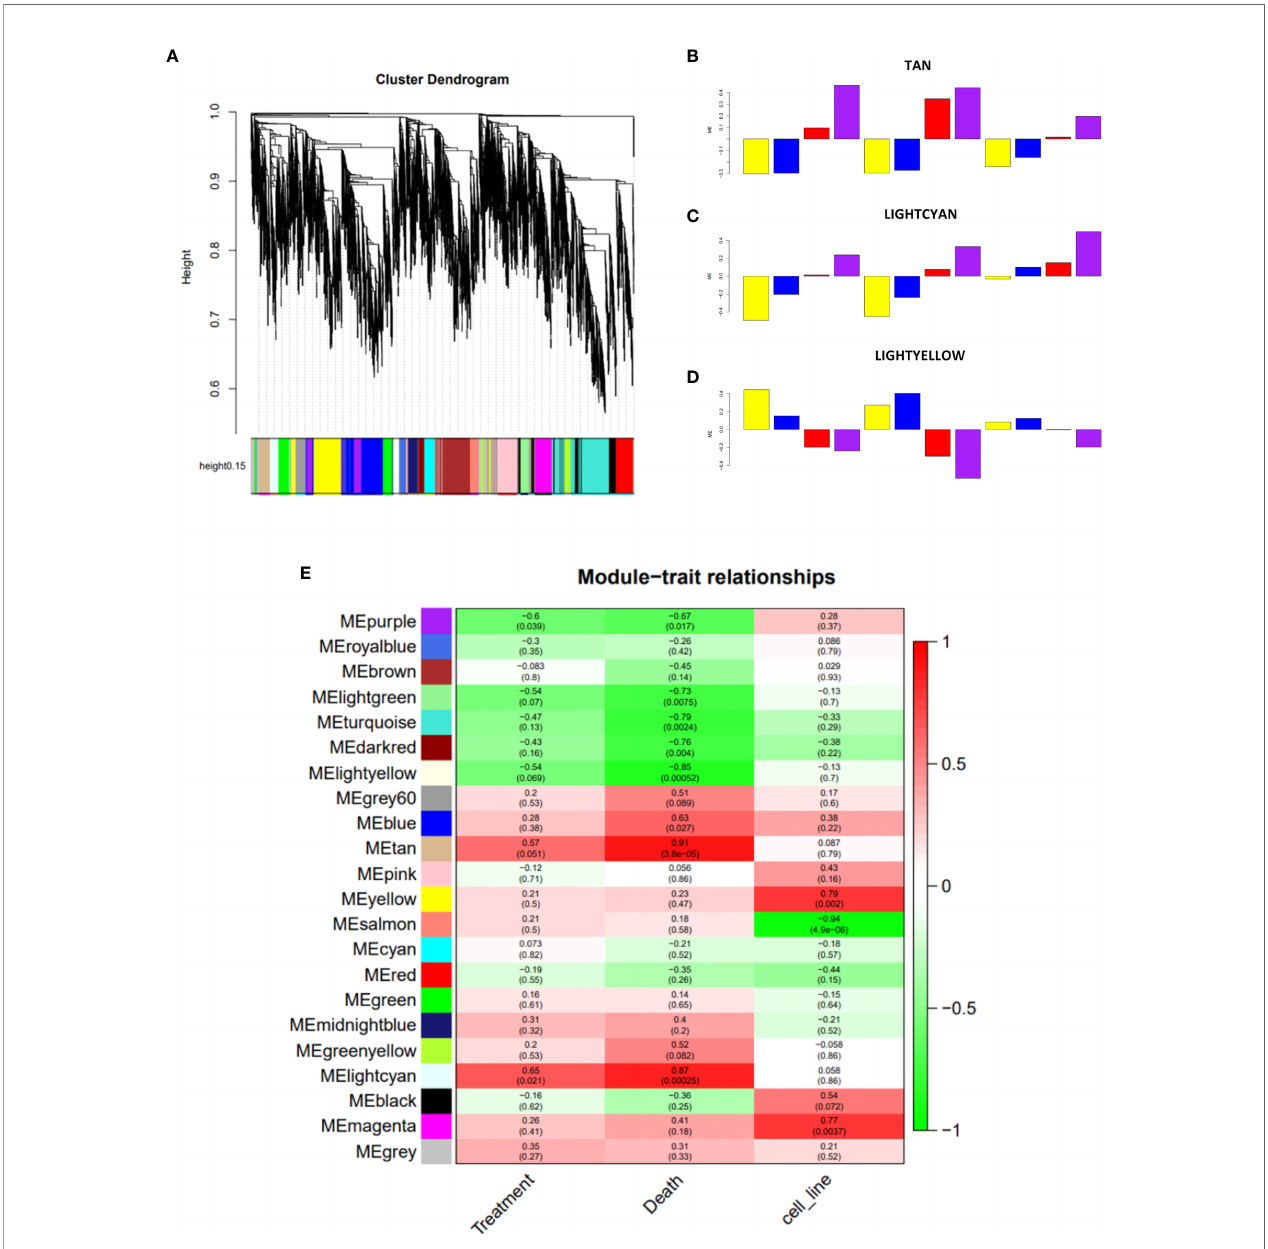
FIGURE 4 | Construction of co-expression network of experiment 1. (A) Network analysis dendrogram showing clustering of genes based on topological overlap for identi fi cation of modules of co-regulated genes in experiment 1. (B – D) Bar plots of the samples representing their variation against the signi fi cant modules Tan, Lightcyan, and Lightyellow, respectively. The color of the bar is associated with the group: DMSO (yellow), treatment with prednisolone (blue), treatment with nimesulide (red), and treatment with nimesulide plus prednisolone (purple). The representation of cell lines in bar plots is in the order HL-60, THP-1, and OCI-AML2. (E) Module – trait relationships showing the sets of genes (modules) generated for experiment 1 and correlation of the detected modules with the variables treatment, death, and cell line. Each row represents a module eigengene; each column to a trait. Each cell contains the corresponding correlation and p-value. DMSO, dimethyl